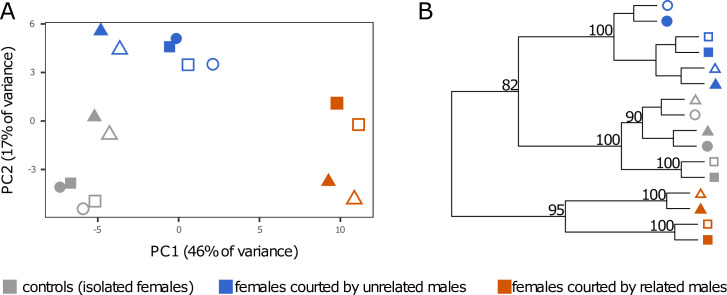
Multivariate analysis of the 16 RNA-seq libraries based on the gene expression profiles of the 500 genes with the highest variance across samples.The samples are clustered by the experimental conditions that females were exposed to. Experimental conditions are represented by the three different colours (grey: control; orange: females courted by related males; blue: courted by unrelated males), shapes indicate the three biological replicates, and the filling of the shape shows the 2 technical replicates. (A) Two-dimensional principal component analysis (PCA) plot. (B) Hierarchical clustering dendrogram based on sample-to-sample distances. Statistical support is indicated by an approximately unbiased P-value with one million multiscale bootstrap resamplings (all bootstrap values were > 50%, those < 80% were not shown for clarity).